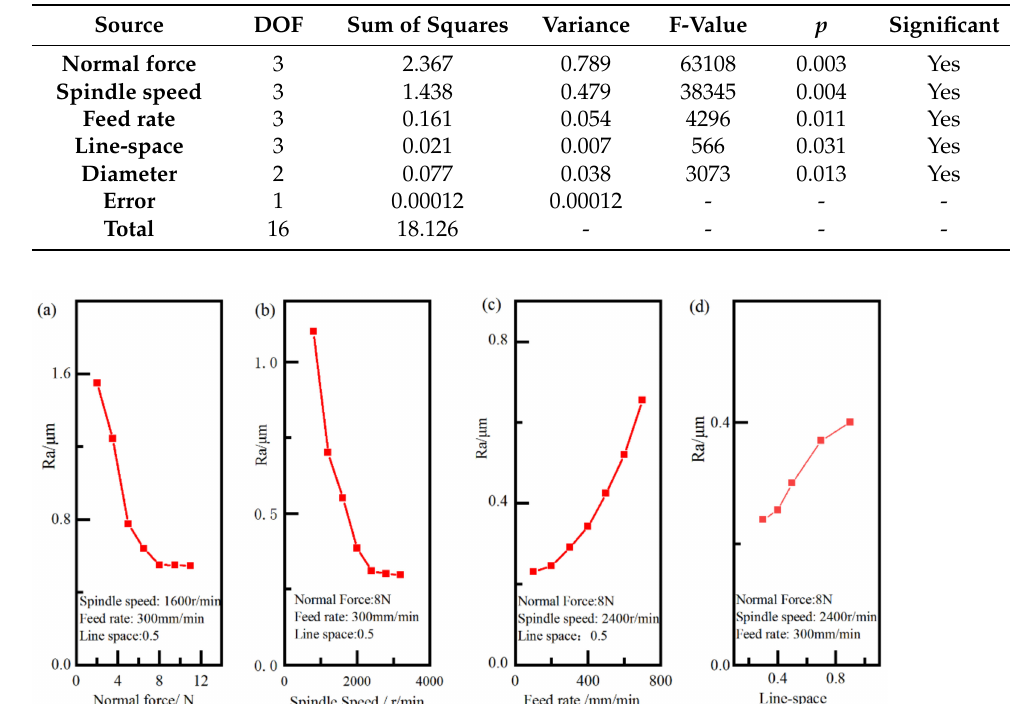
Table 3. The ANOVA Result for the Ra.